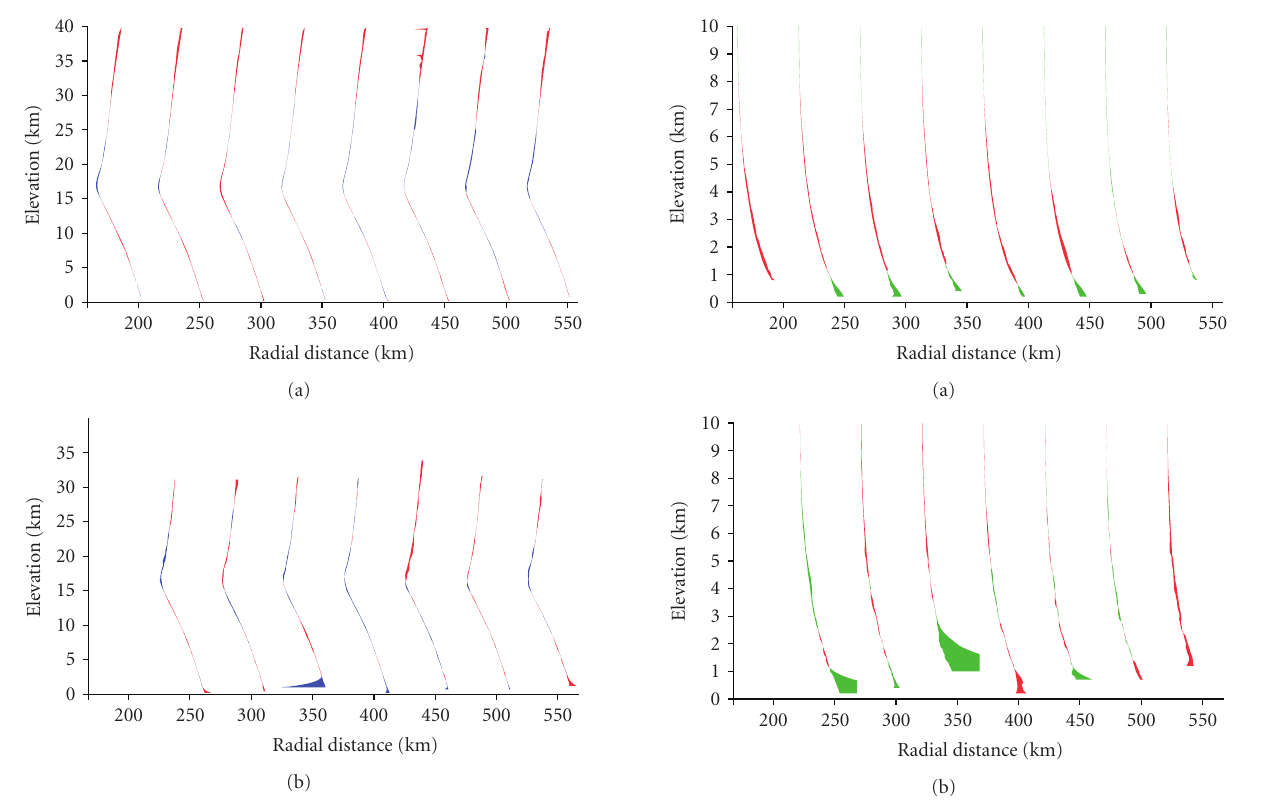
Figure 7: Radial-interval mean intercomparisons for GPS RO observations and (a) colocated global analysis, and (b) colocated radiosonde observation temperature ( ◦ C) profiles. Red shading indicates where radial-interval mean temperature is less than the colocated profiles while the blue shading indicates where the observation temperature is greater than the colocated profiles. The x -axis represents the radial distance (km) the mean profile while the y -axis is vertical elevation (km).